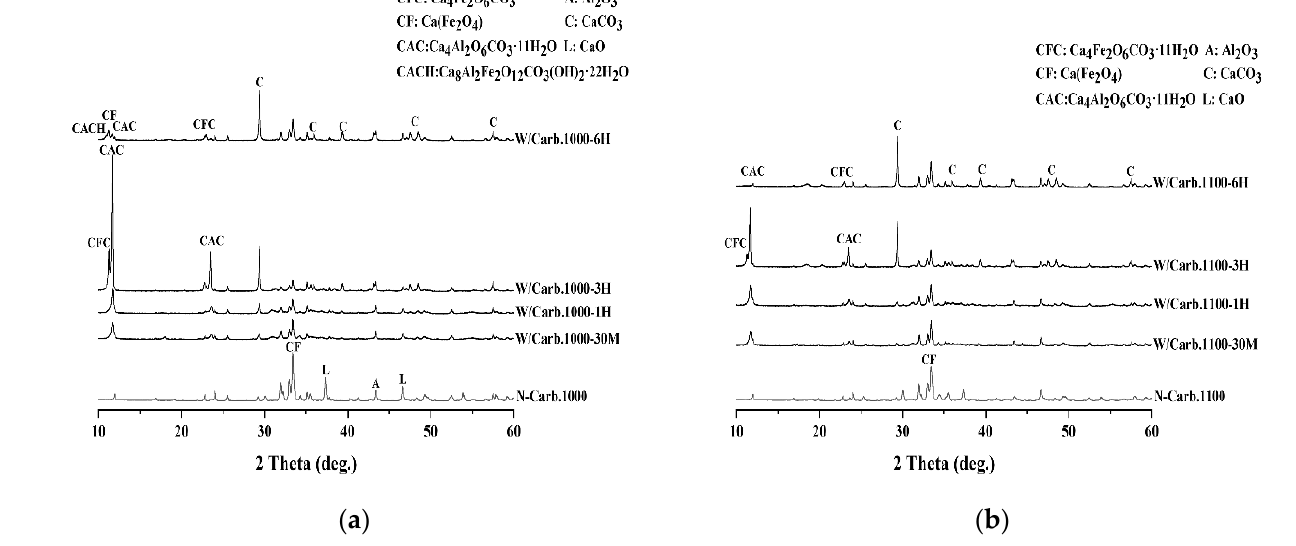
Figure 6. XRD patterns carbonation with wet method. ( a ) 1000 °C; ( b ) 1100 °C.